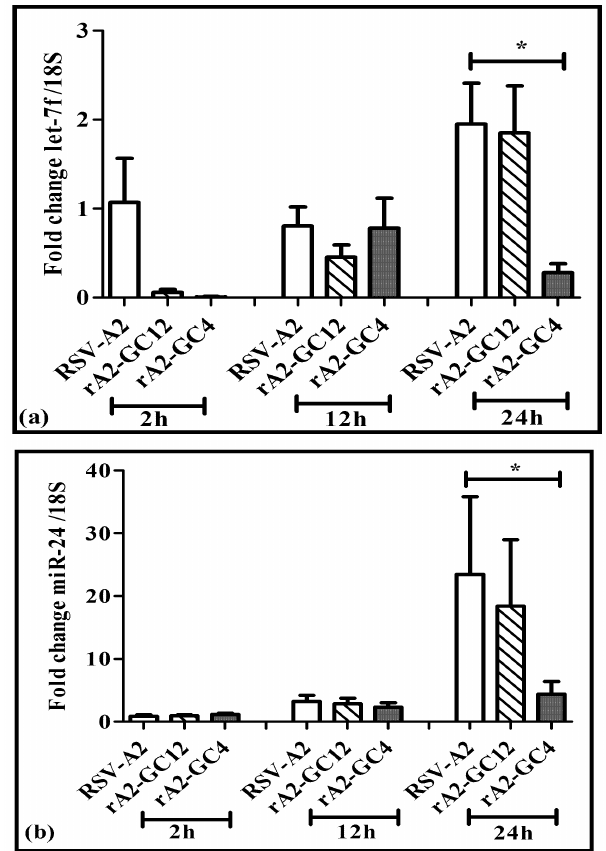
Figure 5. The central conserved region (CCR) of RSV G protein alters miRNA expression. Total RNA from polarized LCC Calu-3 cells mock infected, or infected apically with RSV A2, rA2-GC12 or rA2-GC4 at MOI = 1 was isolated using Trizol as per manufacturer’s protocol. Expression of let-7f ( a ) and miR-24 ( b ) was determined with RT-qPCR using a miRNA specific forward oligo and a universal oligo relative to 18S as housekeeping gene. Data represent ± SEM three independent experiments. * indicates p ≤ 0.05 relative to values from RSV-A2.